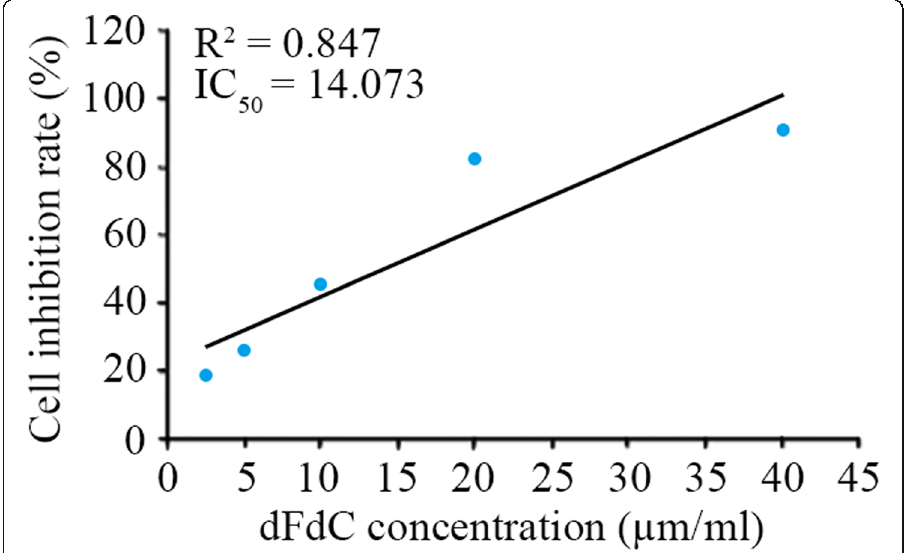
Fig. 1 A scatter plot of the response of dFdC (gemcitabine) concentration (x) respond to the inhibition rate (y) as calculated with the regression equation y = 1.9829x+